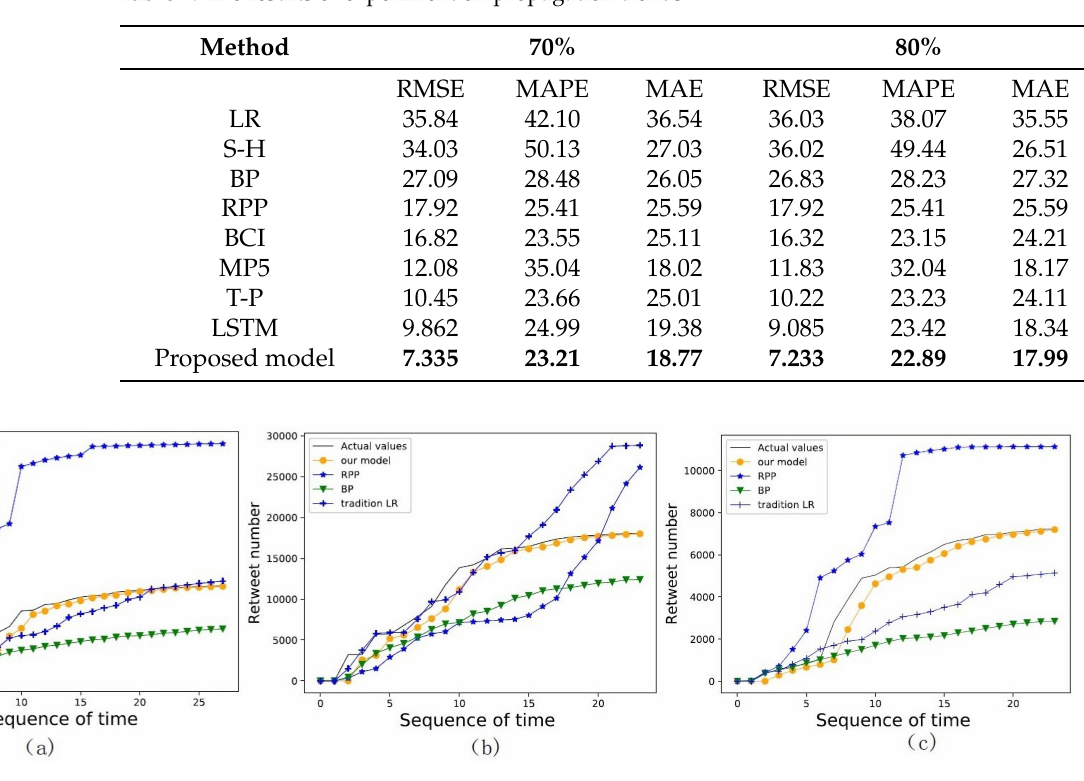
Figure 17. The comparison of model performance. ( a – c ), respectively, are different reposting